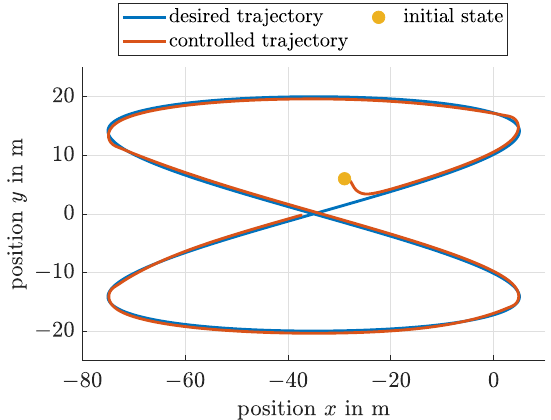
Figure 2. Comparison of the desired and controlled vessel